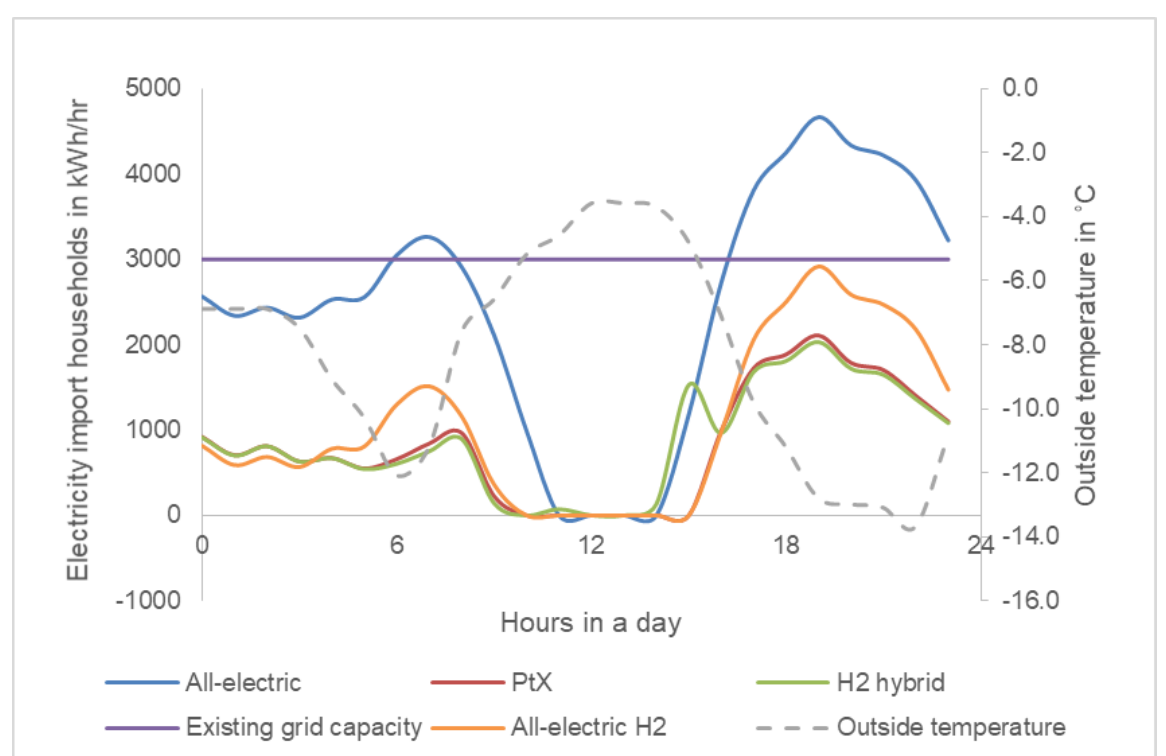
Figure 12. Neighborhood peak demands during a very cold day of the simulation period (6 February 2012), with the outside temperature on the second (right) axis. PtX is the power-to-X scenario. The current maximum grid capacity (3 MW) is shown as a purple line. The all-electric scenario exceeds the current maximum grid capacity of the neighborhood due to high electricity demand for heat pumps, combined with other electricity demand (cooking, appliances, electric car) in the evening hours. The other scenarios have different ways to lower the demand peak, either by shaving the peak with a fuel cell (all-electric H 2 ), using hybrid heat pumps with hydrogen boilers (H 2 hybrid), or a district heating network to fulfill the heat demand (PtX). Another interesting finding is that this cold day was sunny as well, which explains the low electricity import in the middle of the day when the roof PV systems fulfill the electricity demand of the households.